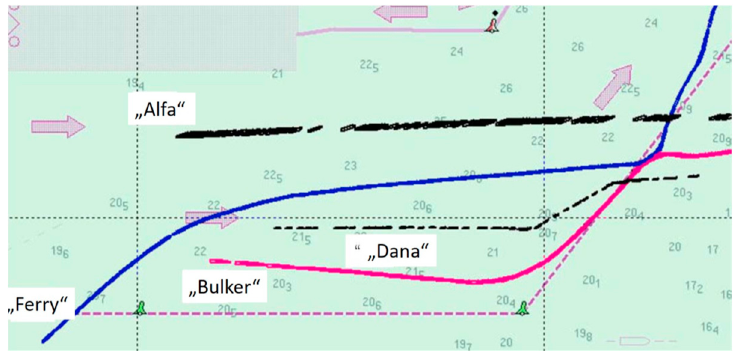
Figure 3. Automatic Identification System (AIS) tracks of collision scenario (adapted from [33]).